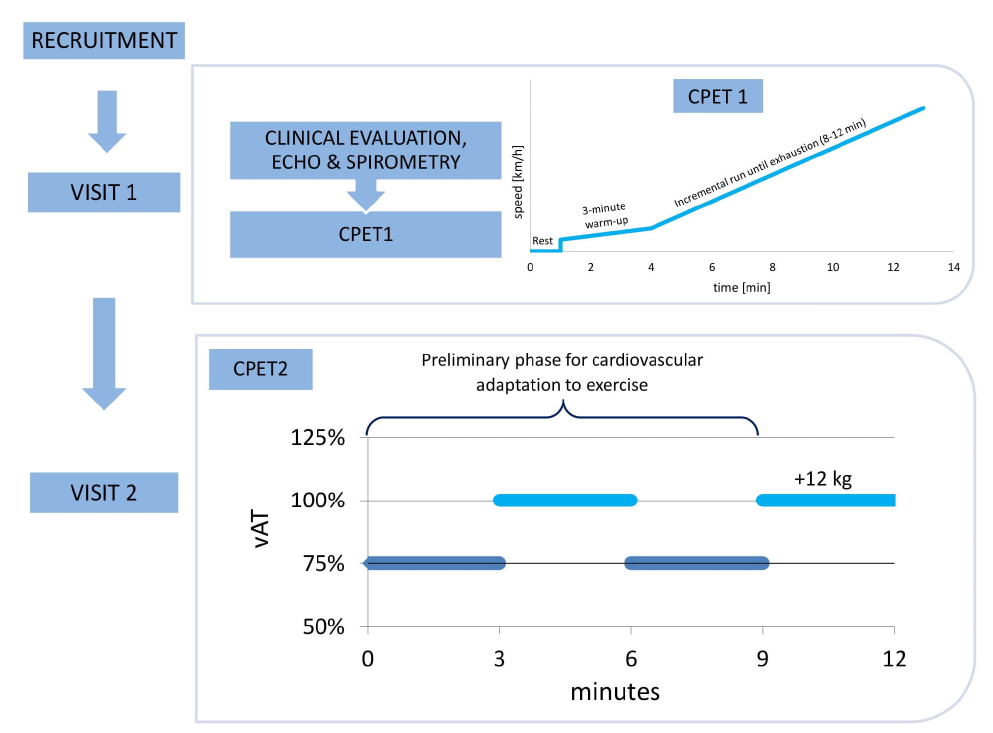
Figure 1. The study flow. Clinical evaluation, echocardiography (ECHO), and spirometry were conducted on VISIT 1, and the progressive cardiopulmonary exercise test (CPET1) was individually tailored to consist of rest, a 3 min warm-up, and an incremental run until exhaustion, aiming to last between 8 and 12 min. On VISIT 2, the second cardiopulmonary exercise test (CPET2) was performed with the exercise intensity set individually for each participant, with the treadmill velocity set at the speed corresponding to the anaerobic threshold (vAT) established during CPET1. For cardiovascular adaptation, each runner ran without the weight vest at 75% vAT for 3 min, then at 100% vAT for 3 min, and at 75% vAT for 3 min. After this 9 min adaptation to the exercise, each runner put on the 12 kg weight vest and ran for 3 min.